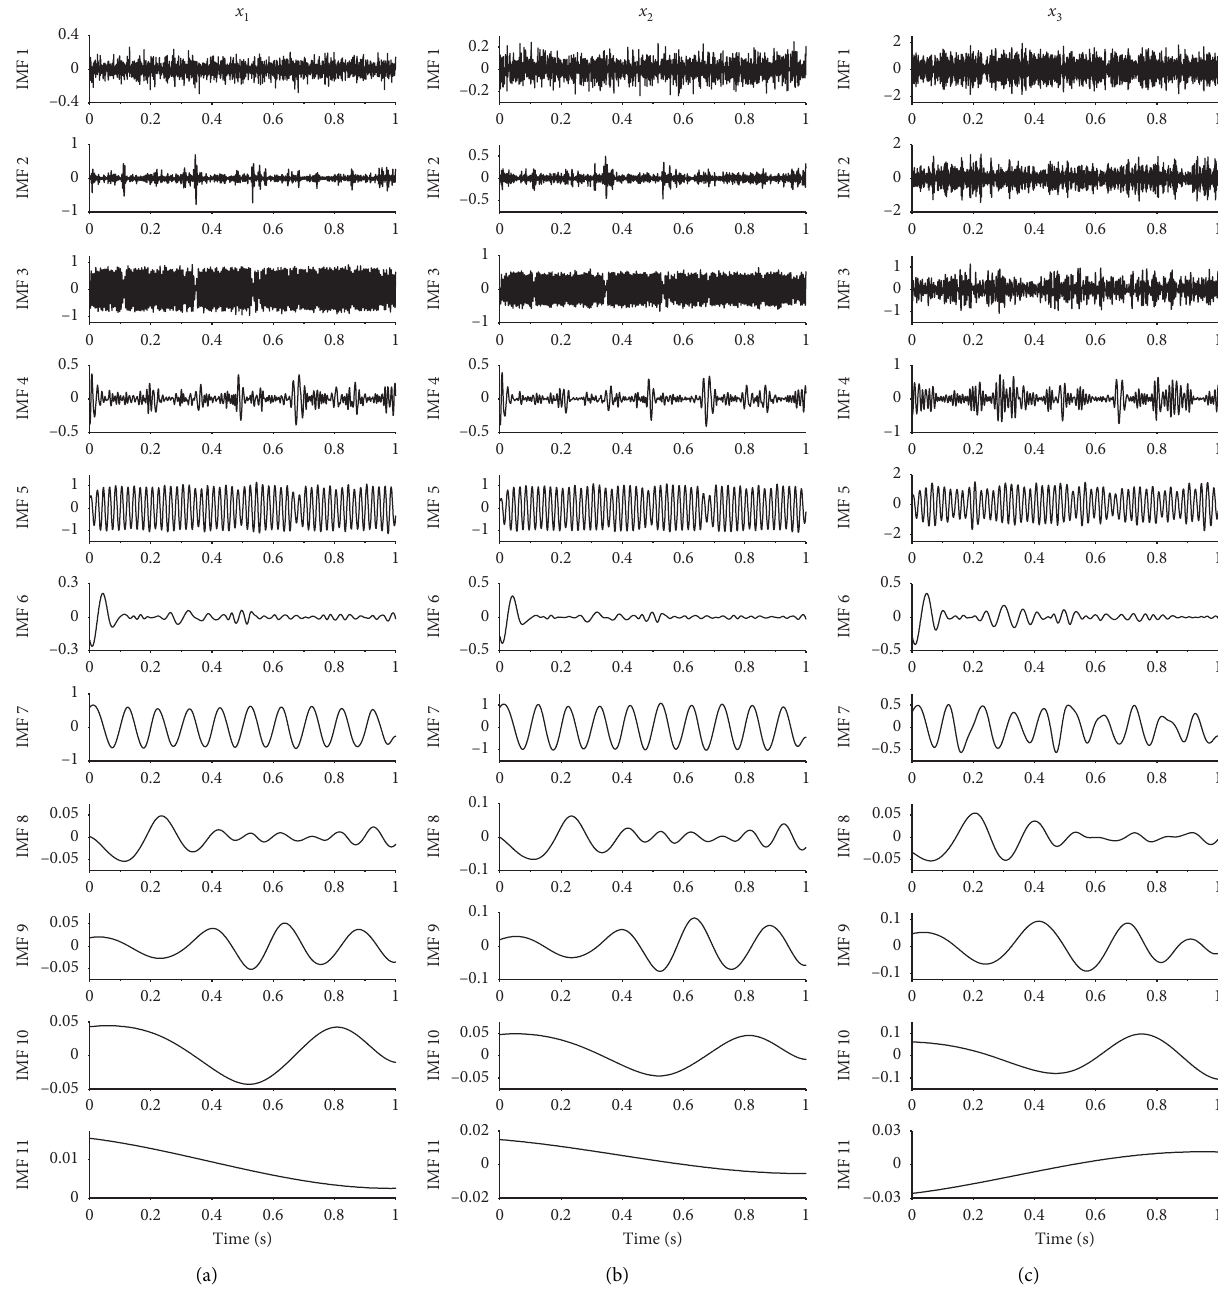
Figure 3: MEMD-based decomposition of simulation